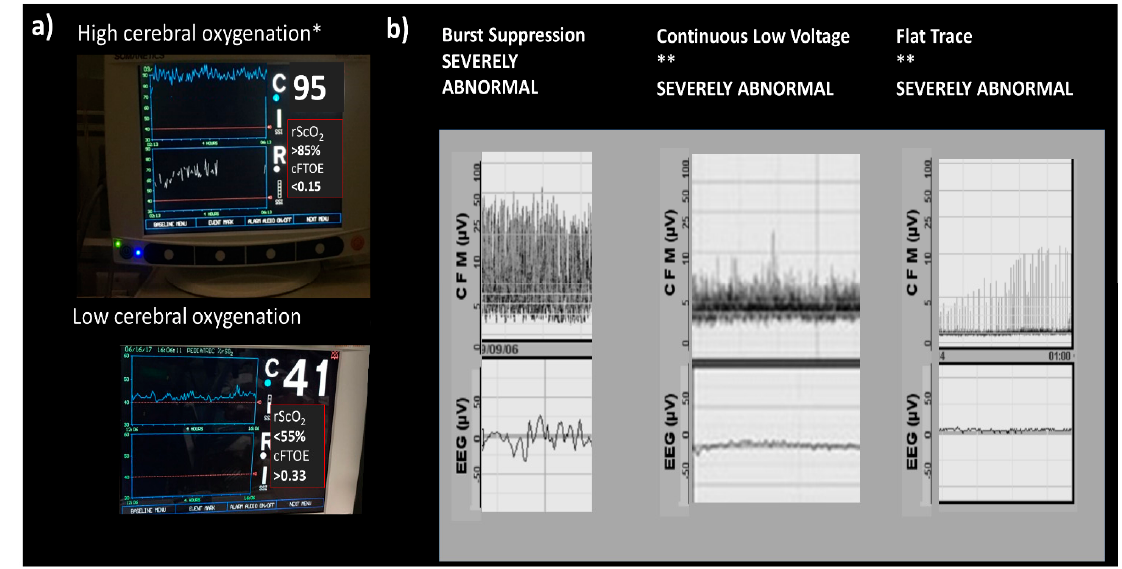
Figure 6. ( a ) High cerebral oxygenation on NIRS * with ( b ) a low ‐ electrical ‐ activity aEEG back ‐